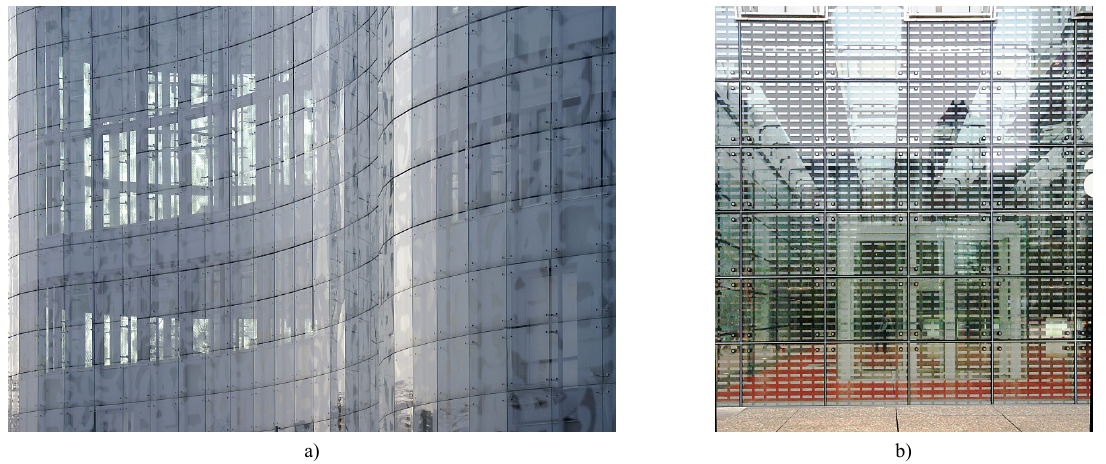
Fig. 4. Interrupted transparency: a) IKMZ Library, Cottbus (arch. Herzog & de Meuron, 2004), b) Ariane Office Tower, La Défense, Paris (arch. Robert Zammit, Jean de Mailly, 1975). Photos by